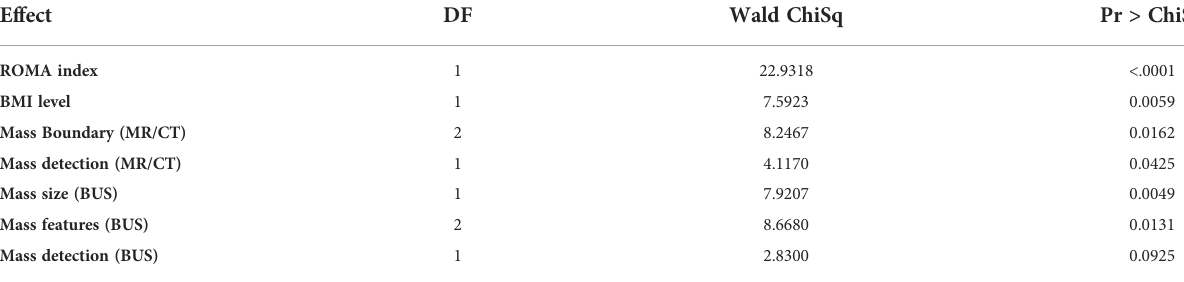
TABLE 2A Multivariate logistic regression analysis. Type 3 effect analysis.